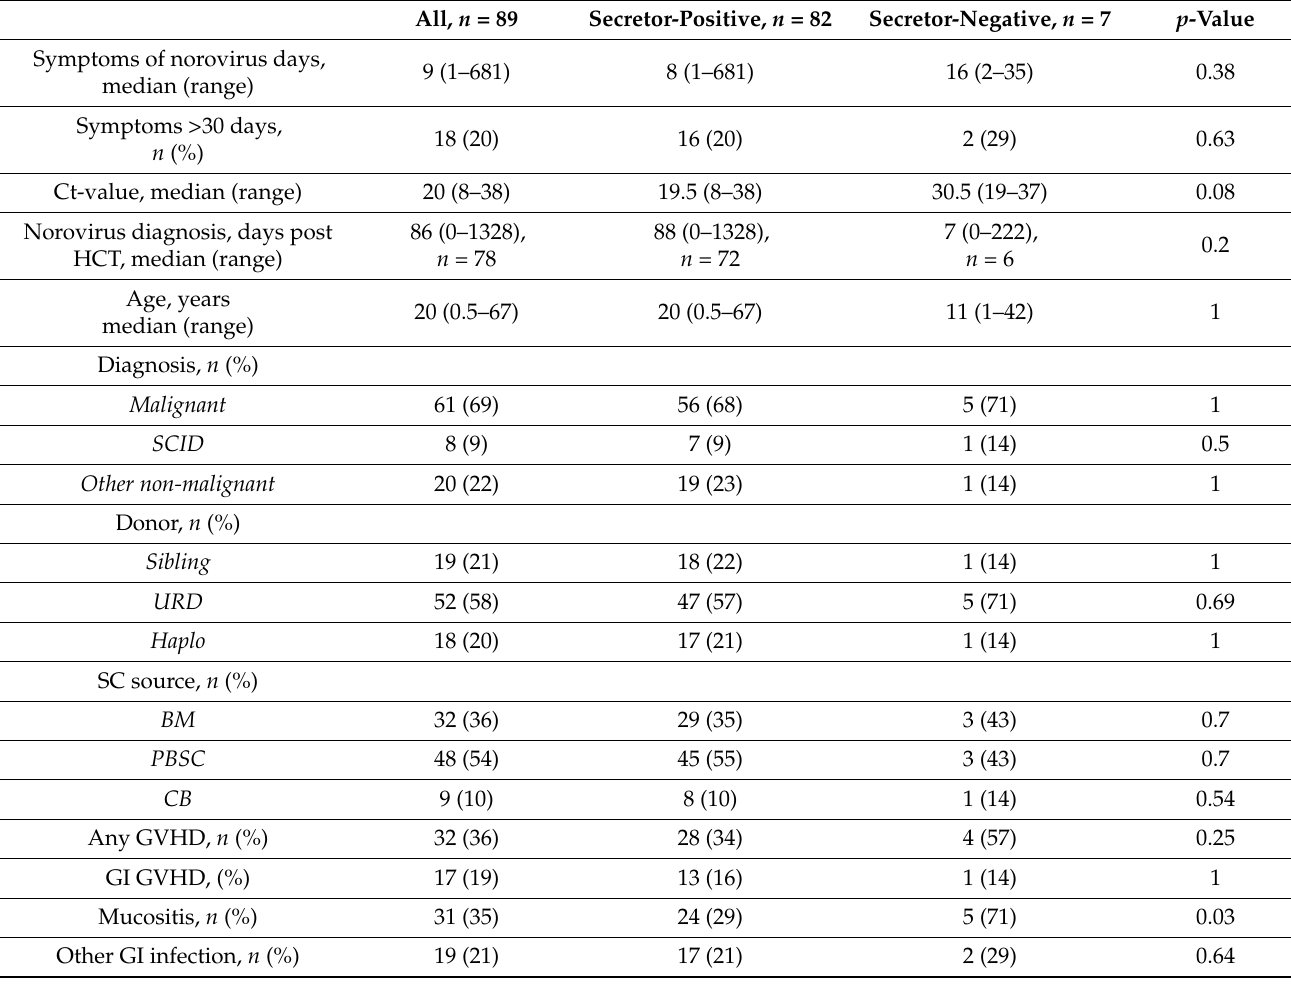
Table 1. Demographical and clinical data in relation to secretor